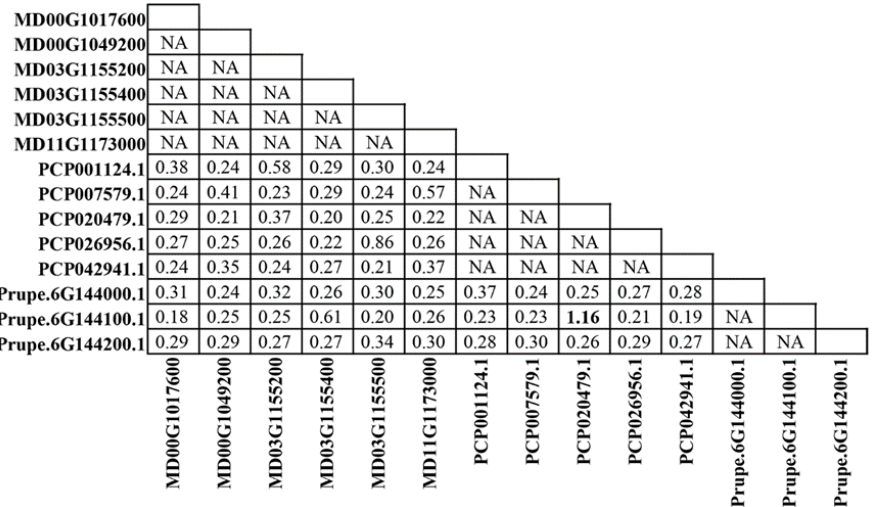
Figure 4. Estimation of ω values of MdALMT gene subgroup I using the maximum-likelihood (ML) method. The ω value higher than 1 is highlighted in black bold.